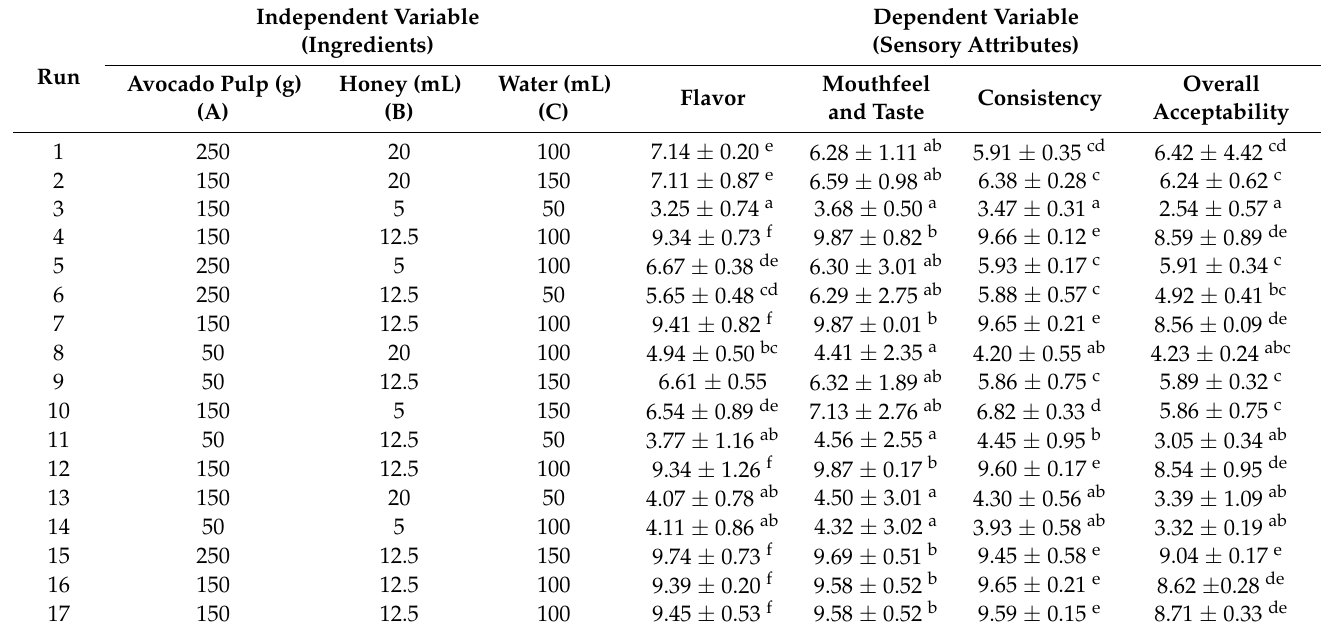
Table 1. Central composite face-centered design with experimental values of response variables.